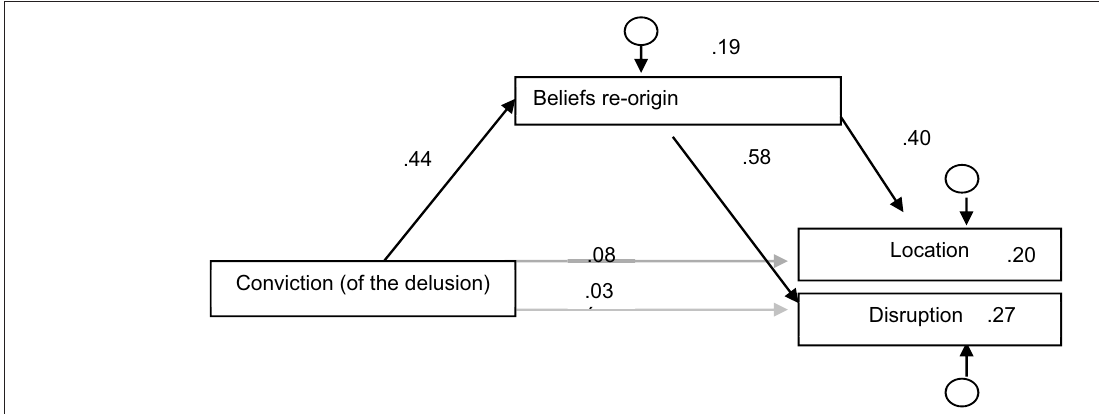
FIGURE 1 | Output of the multiple multivariate linear regression with AMEE.